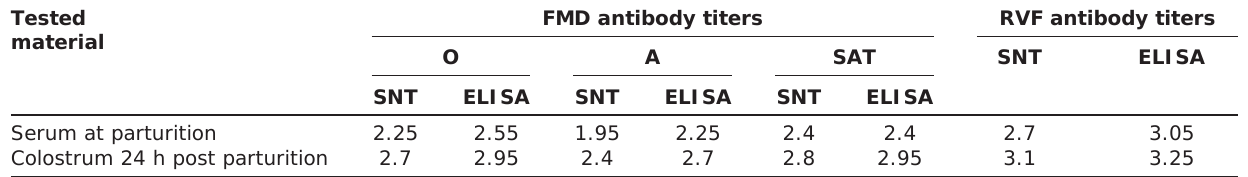
FMD antibody titers